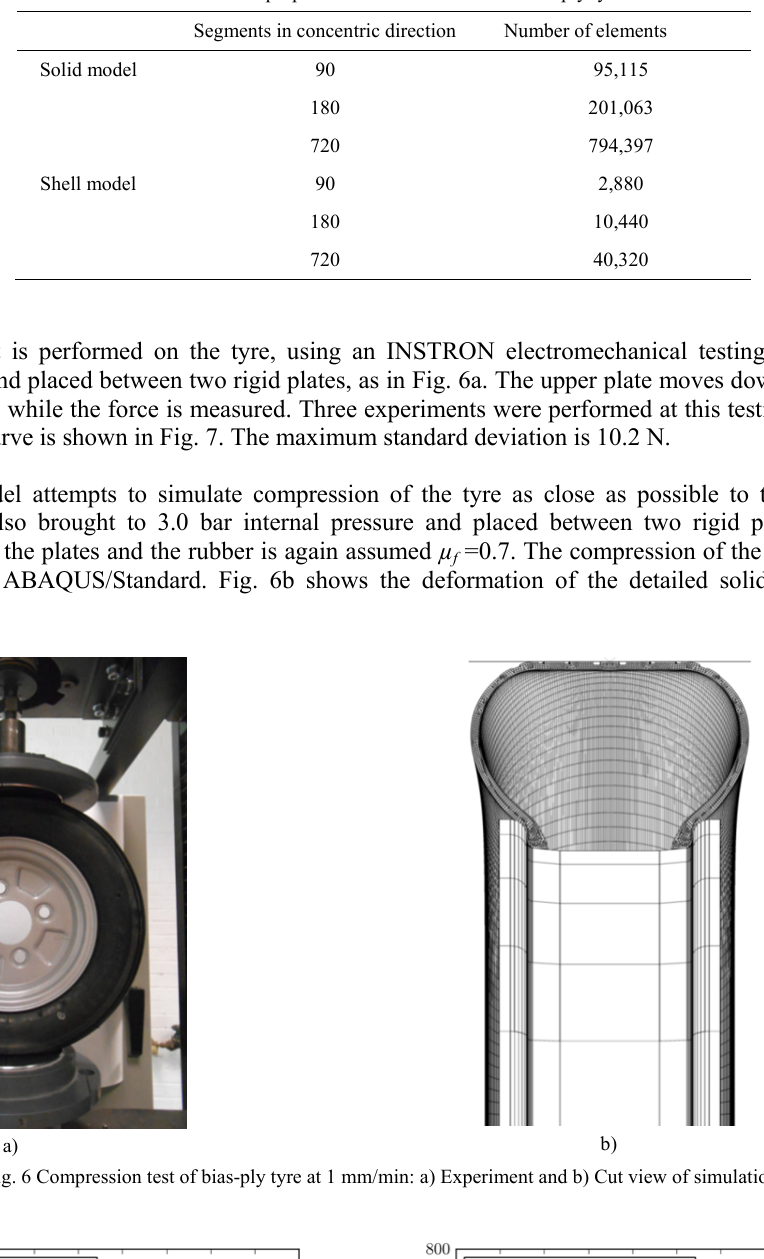
Table 2: Mesh properties for 3D models of the bias-ply tyre